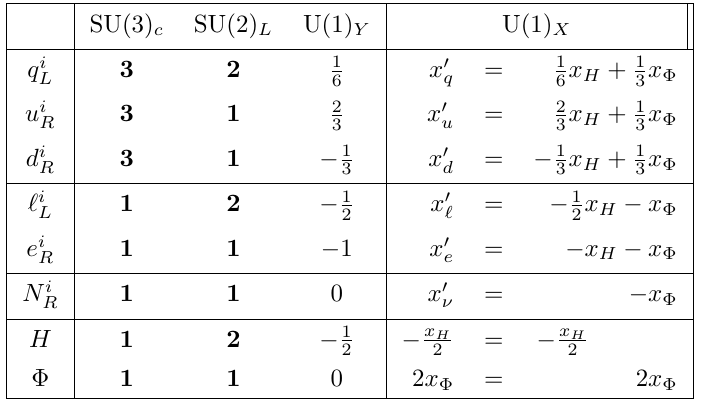
Table 1 . The particle content of the general U(1) X scenario where i is the family indices for the three generations. See text for